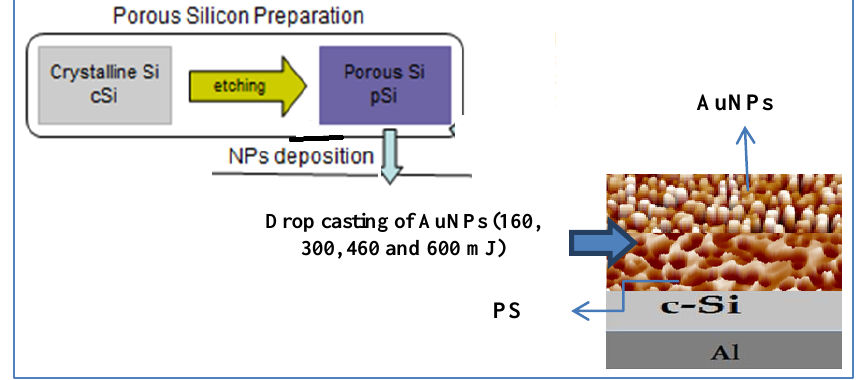
Fig. 2: Simple schematic diagram to AuNPs deposition on